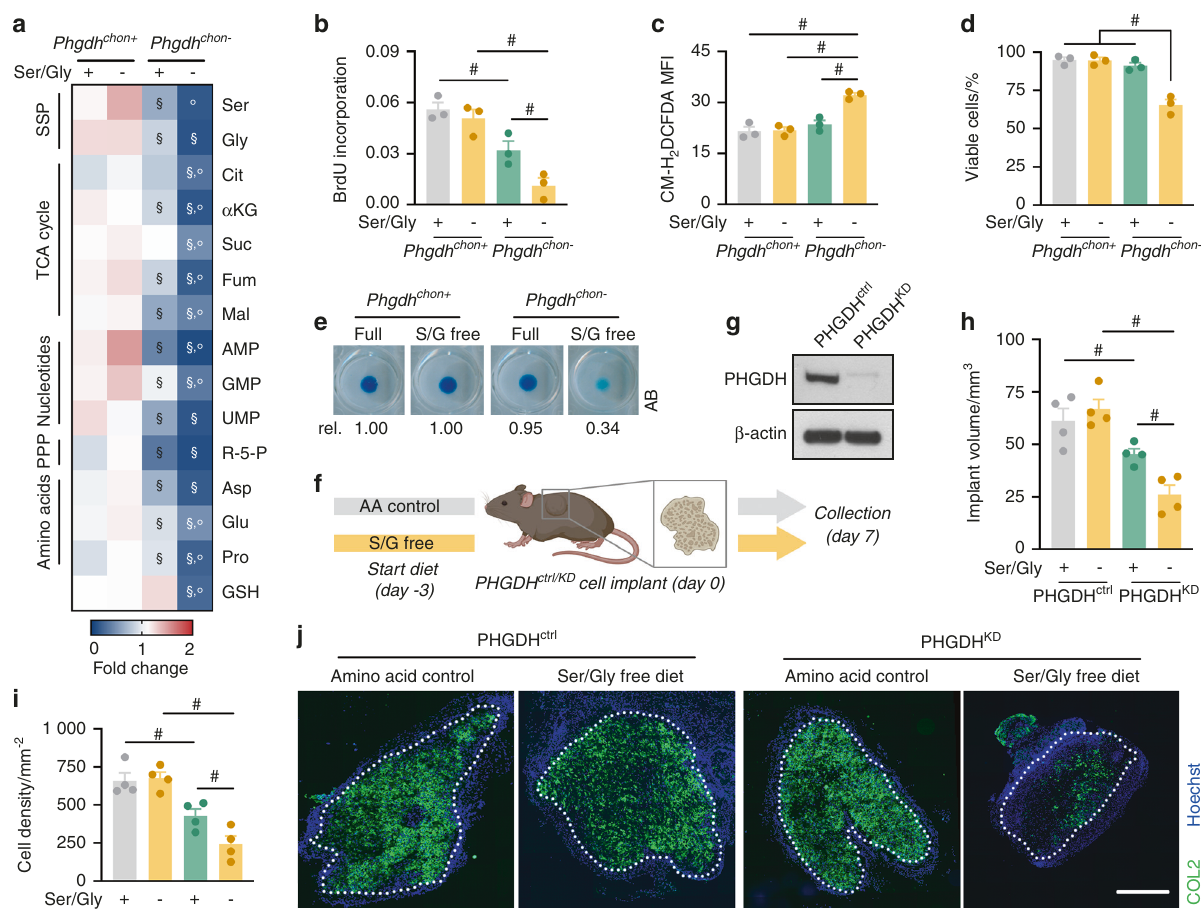
Fig. 7 Combined de fi ciency of serine uptake and de novo serine synthesis severely affect chondrocyte function. a Intracellular levels of the indicated metabolites in chondrocytes isolated from wild-type ( Phgdh chon + ) and chondrocyte-speci fi c PHGDH knockout ( Phgdh chon − ) mice and cultured in complete growth medium ( + ) or serine/glycine-free medium ( − ) ( n = 3). Ser represents serine, Gly represents glycine, Cit represents citrate, α KG represents α -ketoglutarate, Suc represents succinate, Fum represents fumarate, Mal represents malate, R-5-P represents ribose-5-phosphate, Asp represents aspartate, Glu represents glutamate, Pro represents proline and GSH represents reduced glutathione. Proliferation ( b ; quanti fi ed by BrdU incorporation), ROS content ( c ; quanti fi ed by the CM-H 2 DCFDA mean fl uorescence intensity, MFI), viability ( d ; quanti fi ed by AnxV-PI fl ow cytometry, viable cells are AnxV - PI - ) and matrix deposition ( e ; Alcian Blue (AB) staining) of wild-type and PHGDH- de fi cient chondrocytes cultured in complete ( + ) or serine/glycine (S/G)-free medium ( − ) ( n = 3). f Schematic overview of the experimental setup. Chondrogenically primed control (PHGDH ctrl ) or PHGDH-de fi cient (PHGDH KD ) progenitor cells were ectopically implanted into mice fed an amino acid (AA) control diet or a serine/glycine-free diet. Ossicles were collected 7 days after implantation. g Immunoblot of PHGDH and β -actin in PHGDH ctrl and PHGDH KD cells prior to implantation ( n = 4). Volume ( h ) and cell density ( i ) of PHGDH ctrl and PHGDH KD ectopic implants ( n = 4). j COL2 immunostaining in PHGDH ctrl and PHGDH KD ectopic implants ( n = 4). The scale bar represents 500 µm. The data are presented as the means ± SDs; § P < 0.05 vs. Phgdh chon + -complete medium, ° P < 0.05 vs. Phgdh chon − complete medium, # P < 0.05